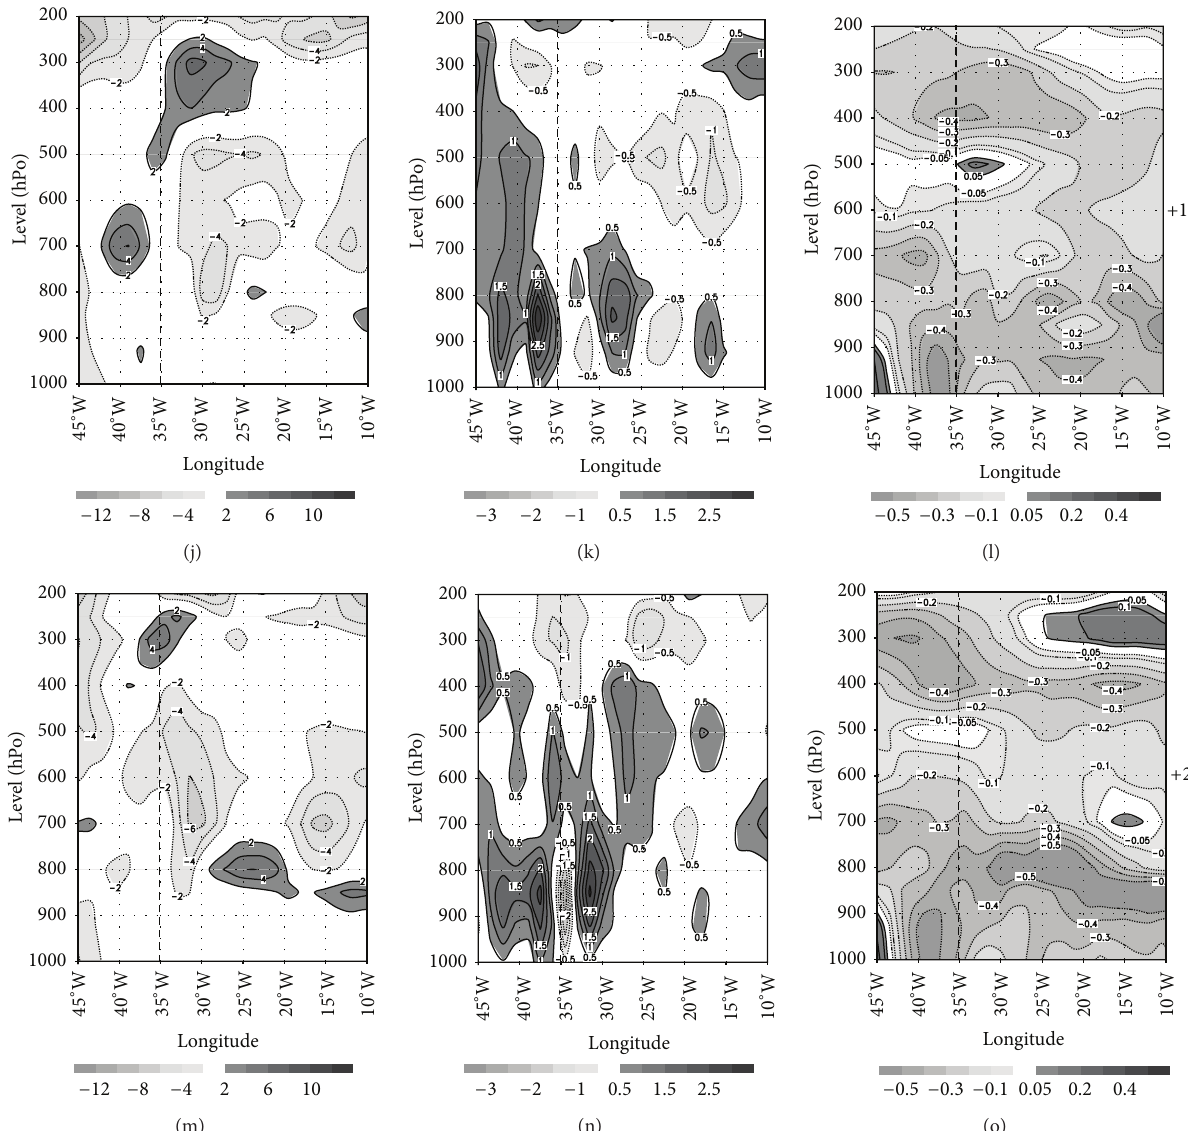
Figure 4: Vertical cross-sections composite anomalies along 8 ∘ S of the relative humidity (%, left column), vertical velocity (m ⋅ s −1 , center column), and temperature ( ∘ C, right column) in the period from April to July 2006. The vertical dashed line at 35 ∘ W mark the subjectively estimated longitudinal position of littoral ENEB.